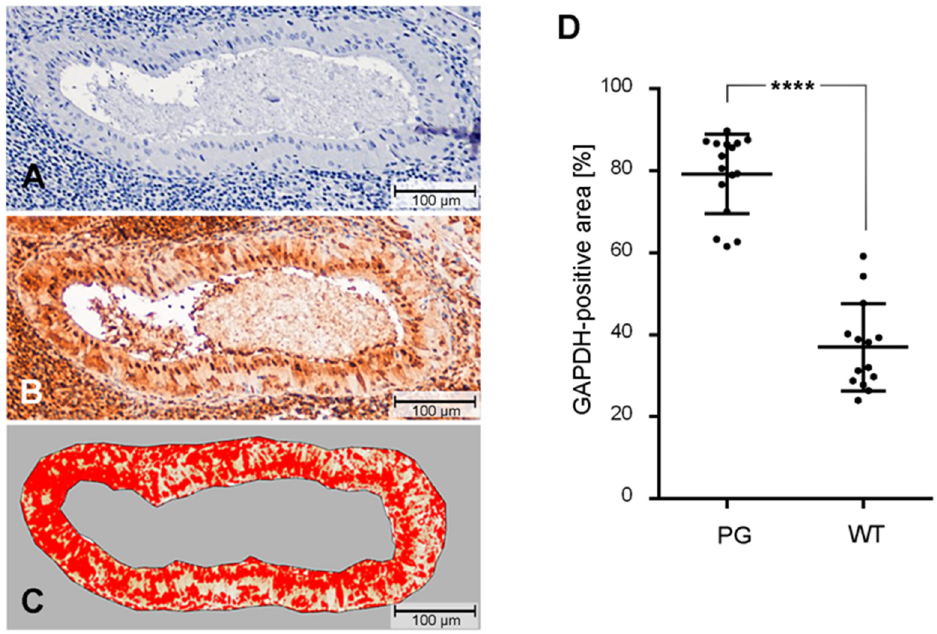
Figure 3. Evaluation of GAPDH immunoreactivity in ductal cells of normal parotid glands and Warthin tumor oncocytes. Tissue slices of parotid glands (PG) or Warthin tumors (WT) ( A ) were immunostained with a GAPDH specific antibody ( B ), slices were digitized and the GAPDH positive (red) area was analyzed with the program ImageJ/Fiji to receive the percentage of GAPDH positive oncocytes or ductal cells ( C ) [30]. Statistical differences between the two groups were calculated by a two-tailed unpaired t-test with Welch’s correction. ( D ) Box plot of n = 16 PG and n = 14 WT. **** p < 0.0001.